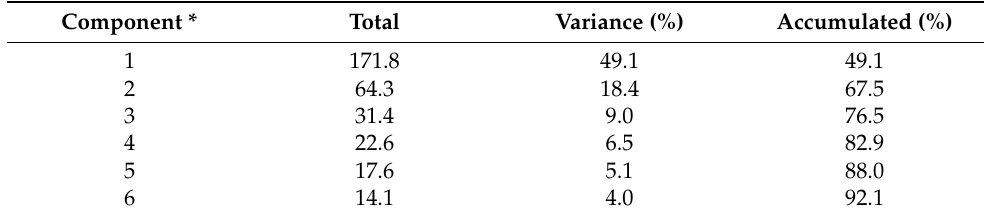
Table 4. Total accumulated variance according to multivariate factor